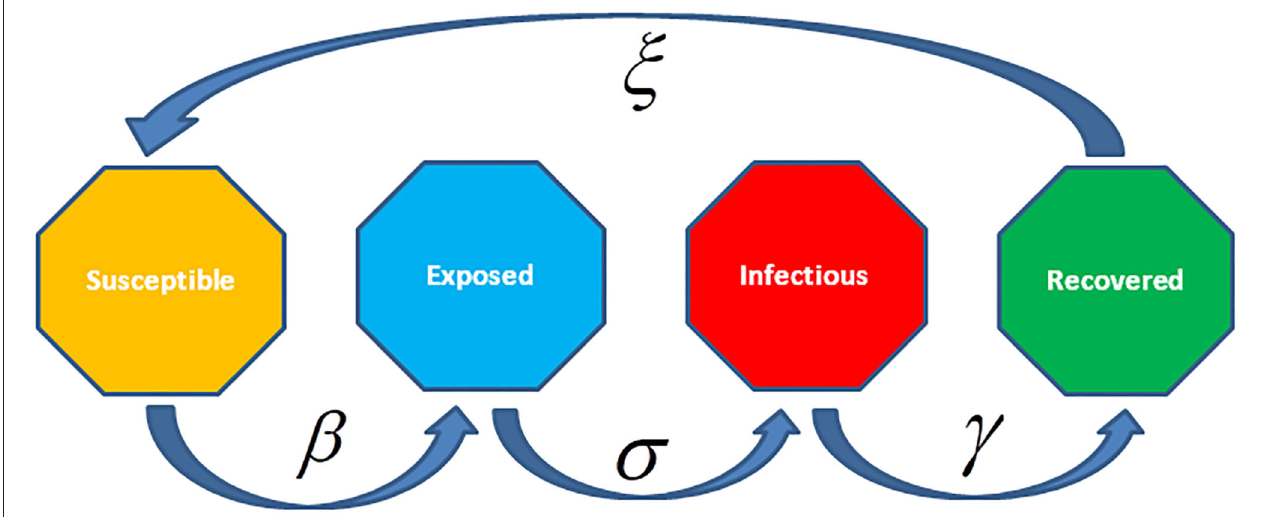
FIGURE 11 | The Susceptible-Exposed-Infected-Recovered- Susceptible (SEIRS) model considers people carry lifelong immunity to disease after recovery, but for many diseases, the immunity deteriorates over time. In such cases, the SEIRS model is applied to permit recovered individuals to come back to a susceptible state. The parameter ξ represents the rate to be susceptible after recovery because of decay in